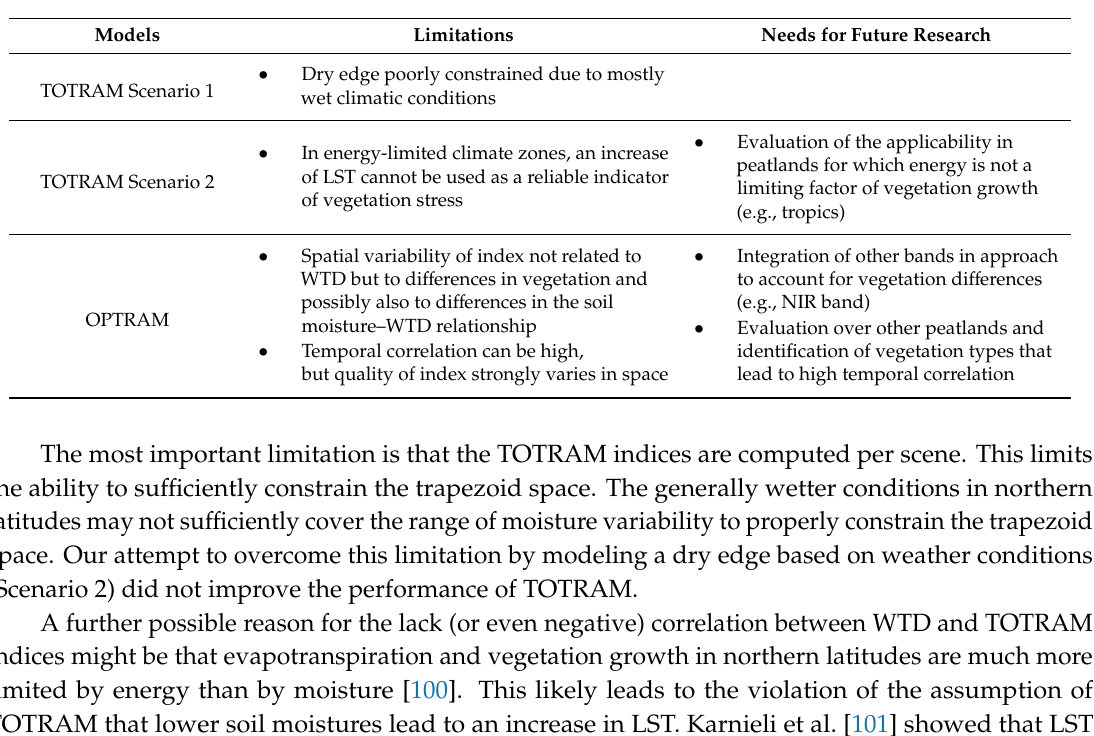
Table 1. TOTRAM and OPTRAM for monitoring WTD in northern bogs: main limitations and needs for future